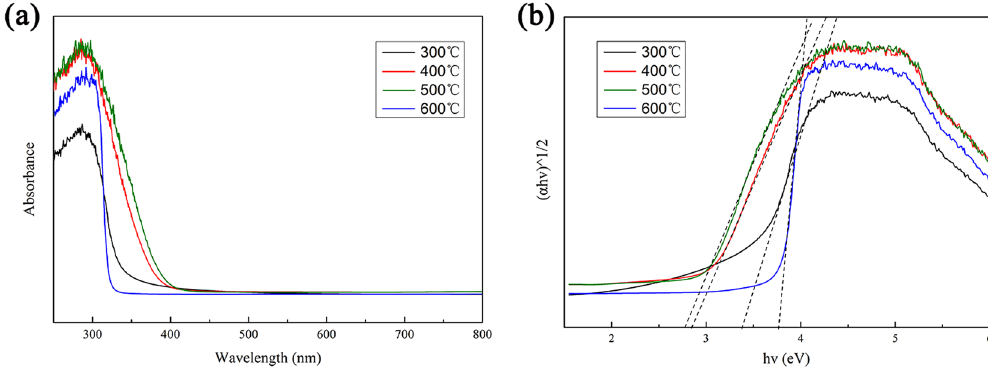
Figure 8. UV-Vis spectra of the as-prepared porous monoliths of MoO 3 nanoplates.